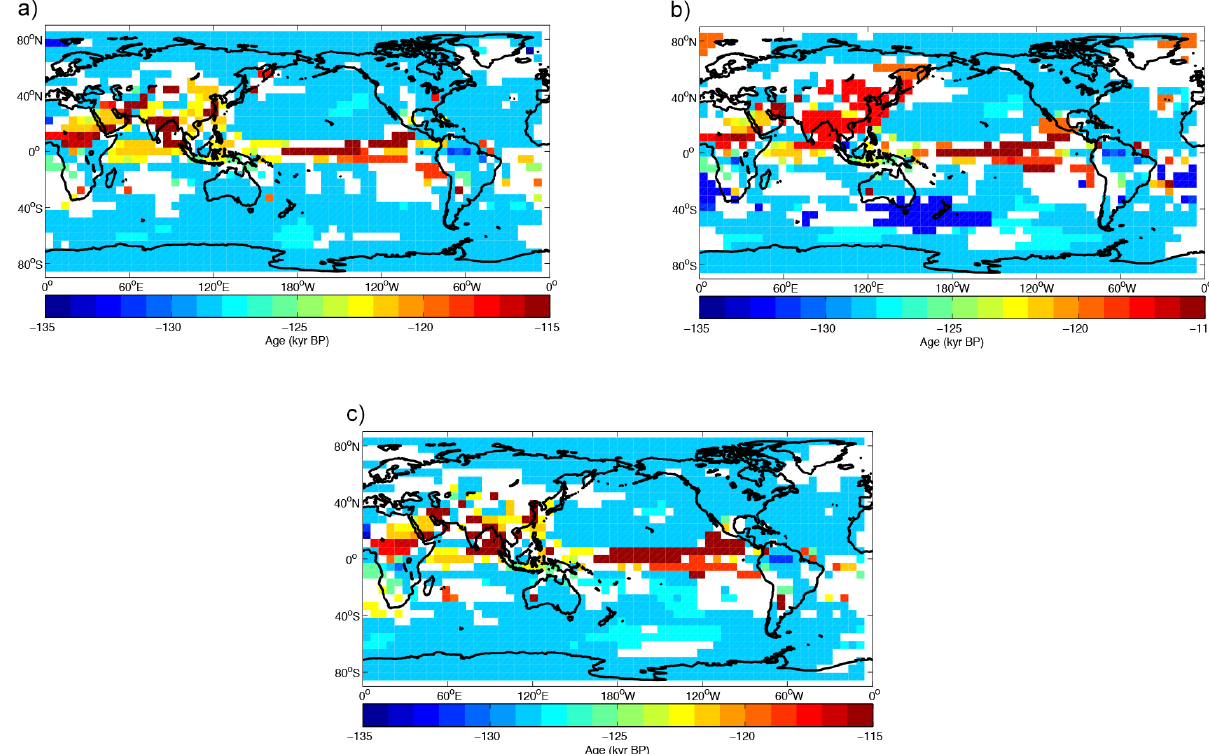
Figure 11. Timing (in kyr) of the simulated LIG surface temperature maximum (MWT) in annual mean for (a) topoGR, (b) fwfGR and (c)